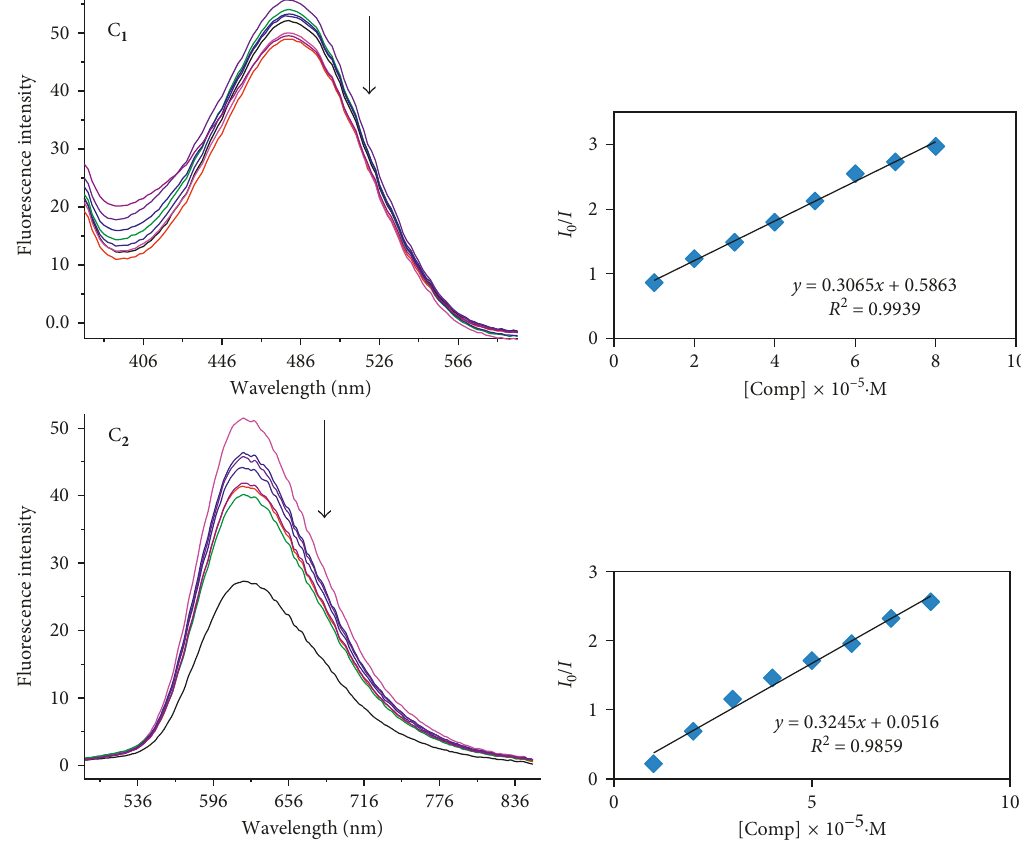
Figure 6: Fluorescence quenching curves of EB-DNA in the presence of complex (C 1 and C 2 ) at the concentration 0–35 μ M at the interval of 5 in Tris-HCl/NaCl buffer (pH 7.2). The arrow indicates the effect of increasing the complex concentration on the fluorescence emission of ethidium bromide bound CT-DNA. The plot shows the linear fit of F o / F versus